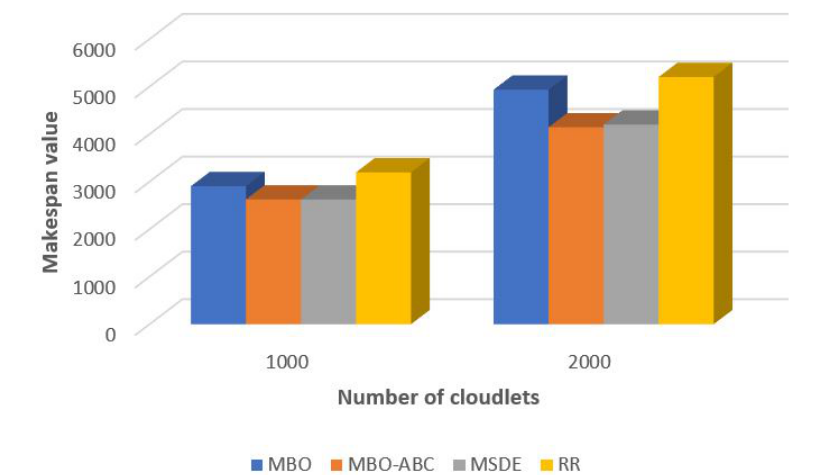
Figure 15. Comparative analysis—MBO-ABC vs. MSDE vs. RR using HPC2N real trace for a small number of tasks.